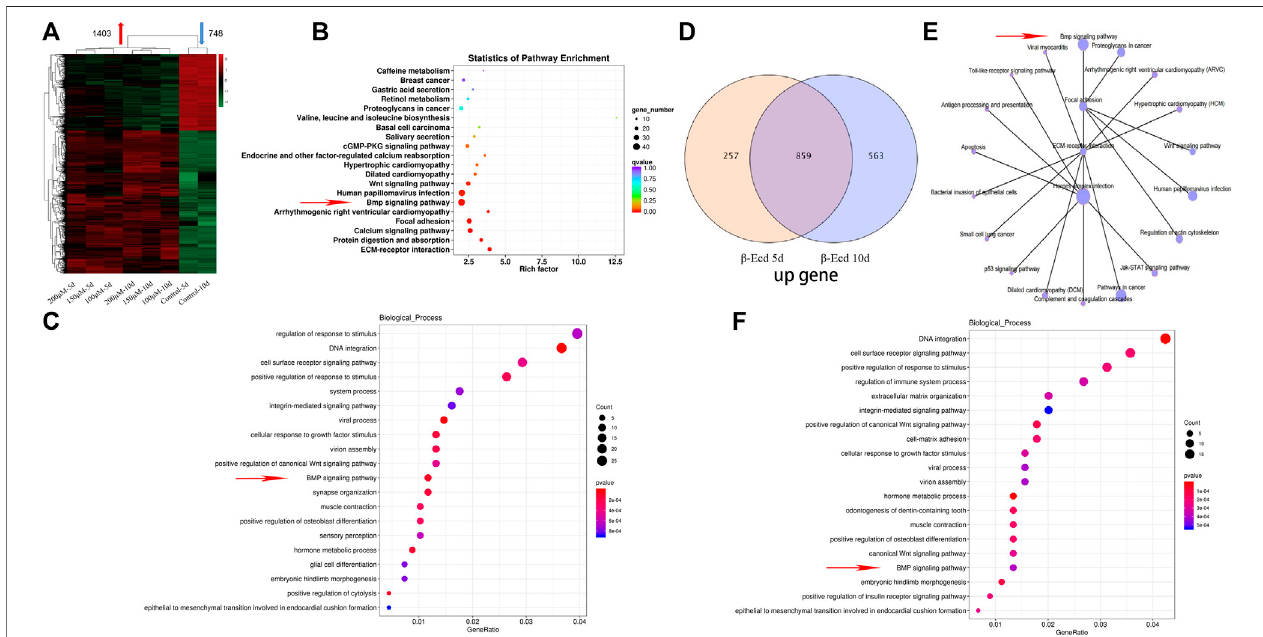
FIGURE 2 | Intracellular RNA was extracted at 5 and 10 days of culture, and transcriptome RNA sequencing analysis was performed. (A) Cluster analysis of differentially expressed genes |log2 ratio| > 1 and FDR < 0.05 in the 0 – 200 μ M β -Ecd group compared to 5 and 10 days. (B) Differential gene enrichment of the KEGG signaling pathway. (C) Analysis of cell biological processes of differential gene enrichment biological processes. (D) Venn analysis of differentially expressed genes. (E) KEGG signaling pathway of mRNAs associated with osteogenic differentiation. (F) Analysis of the cell biology enrichment process of 859 genes upregulated in the Venn